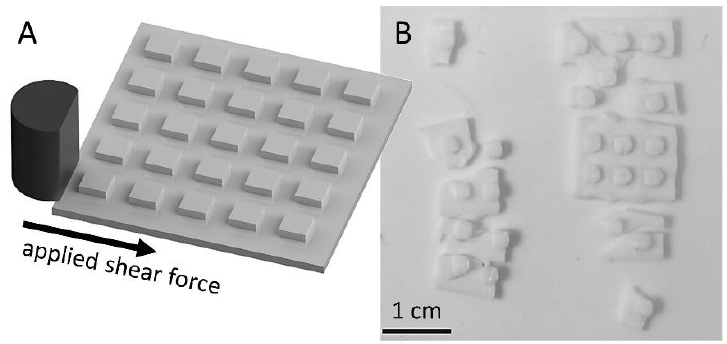
Figure 2. ( A ) Printed squares with an edge length of 2.5 mm and a height of 1 mm arranged on a ground plate of 3 × 3 cm 2 and a height of 1 mm were sheared off and the force until breakage was measured. ( B ) In all cases, the 1 mm thick carrier plate was broken, if a breakage had occurred. In six cases, neither the base plate nor the squares with a maximum of 300 N could be destroyed.